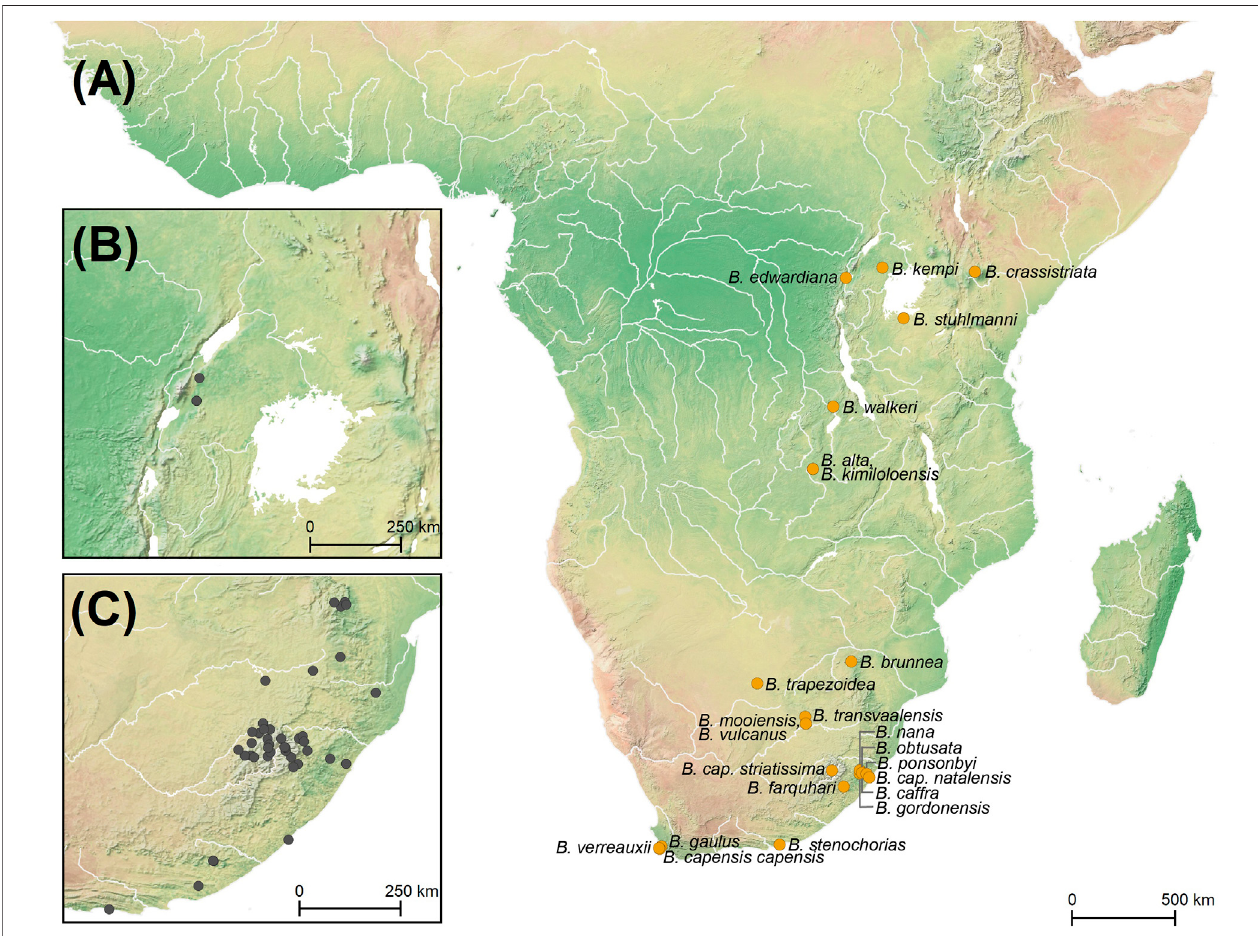
FIGURE2|(A) MapofAfricawiththetypelocalitiesof22 Burnupia speciesandthreesubspeciesof Burnupiacapensis markedingolddots,withsubmapsshowing (B) the sampling localities of Burnupia incorporated into the current study from eastern Africa and (C) southern Africa (inclusive of the Lesotho Highlands) in grey dots.